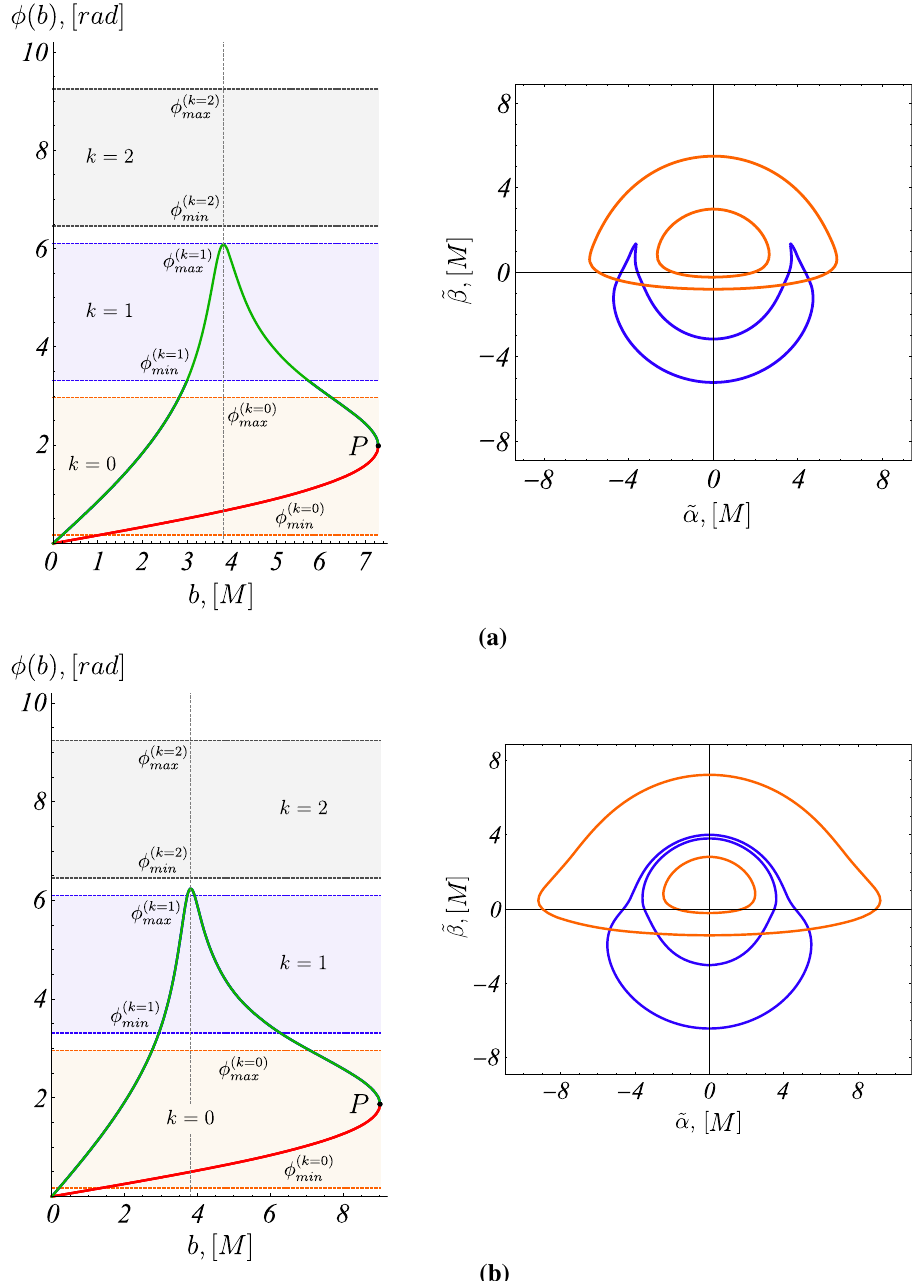
Fig. 9 Image formation diagrams and the corresponding observable images for the circular orbits located at r = 7 . 62 M ( a ) and r = 9 . 124 M ( b ) in the spacetime of the strongly naked singularity with γ = 0 .